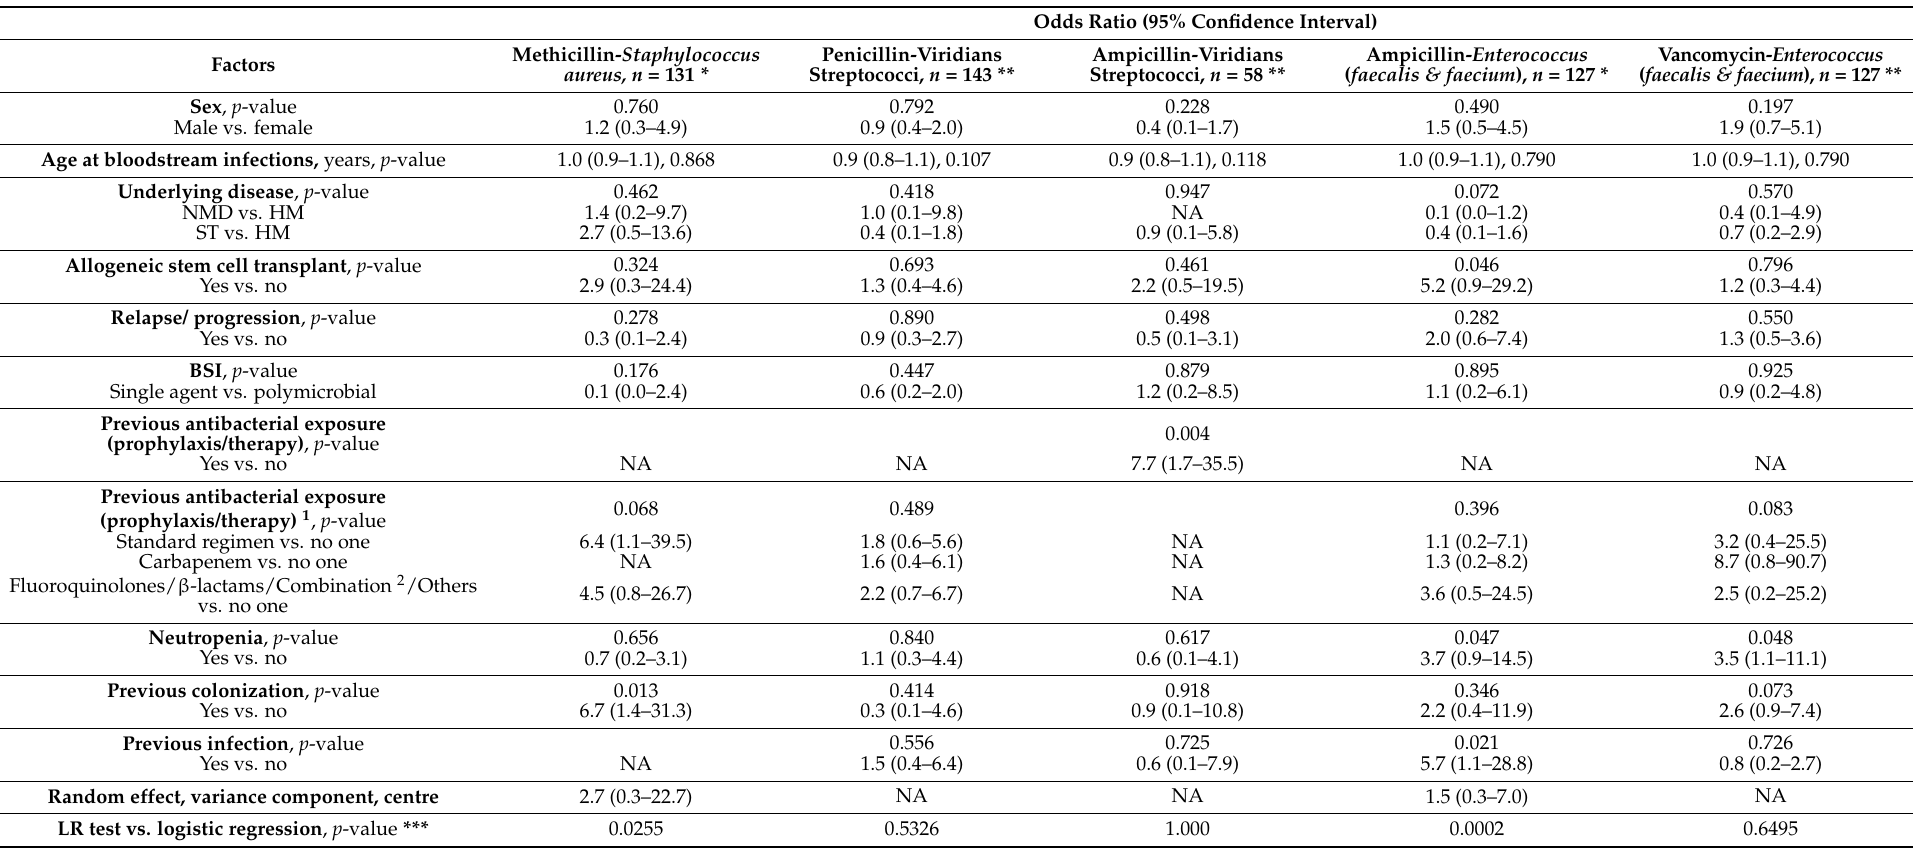
Table 3. Multivariable logistic regression models for models for BSI due to antibiotic resistant among